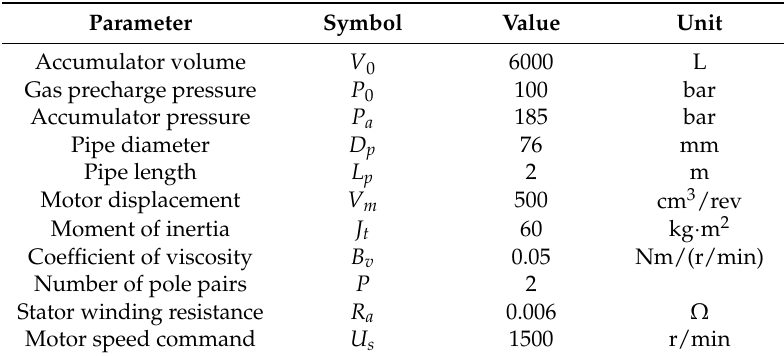
Table 1. Main parameters in